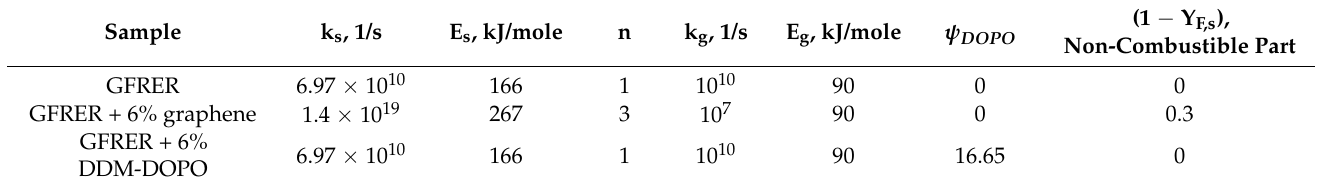
Table 5. Kinetic parameters of pyrolysis and rates of gas-phase combustion macroreaction used in the